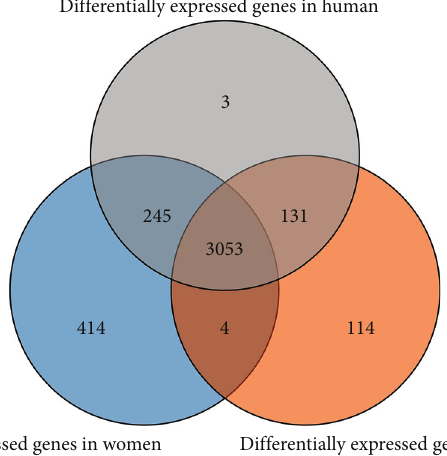
Figure 7: Venn diagram of DEGs. The DEGs were identi fi ed from the three microarray datasets showed overlaps of 3053 in both male and